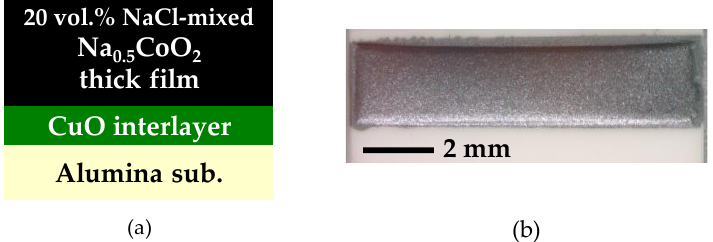
Figure 2. ( a ) Cross-sectional schematic and ( b ) photograph of a partially improved Na 0.5 CoO 2 thick film with NaCl mixing and a CuO interlayer introduction.